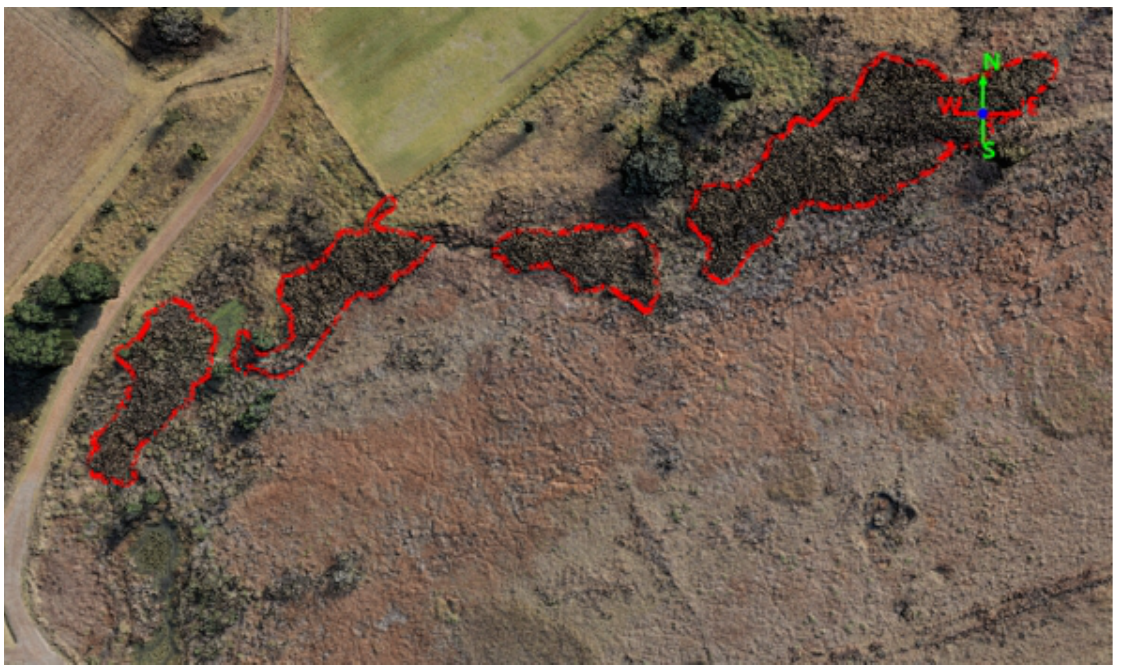
Figure 5. The delineation of wetland vegetation to assist with the determination of surface roughness within the wetland (orthophoto as a texture over DEM).